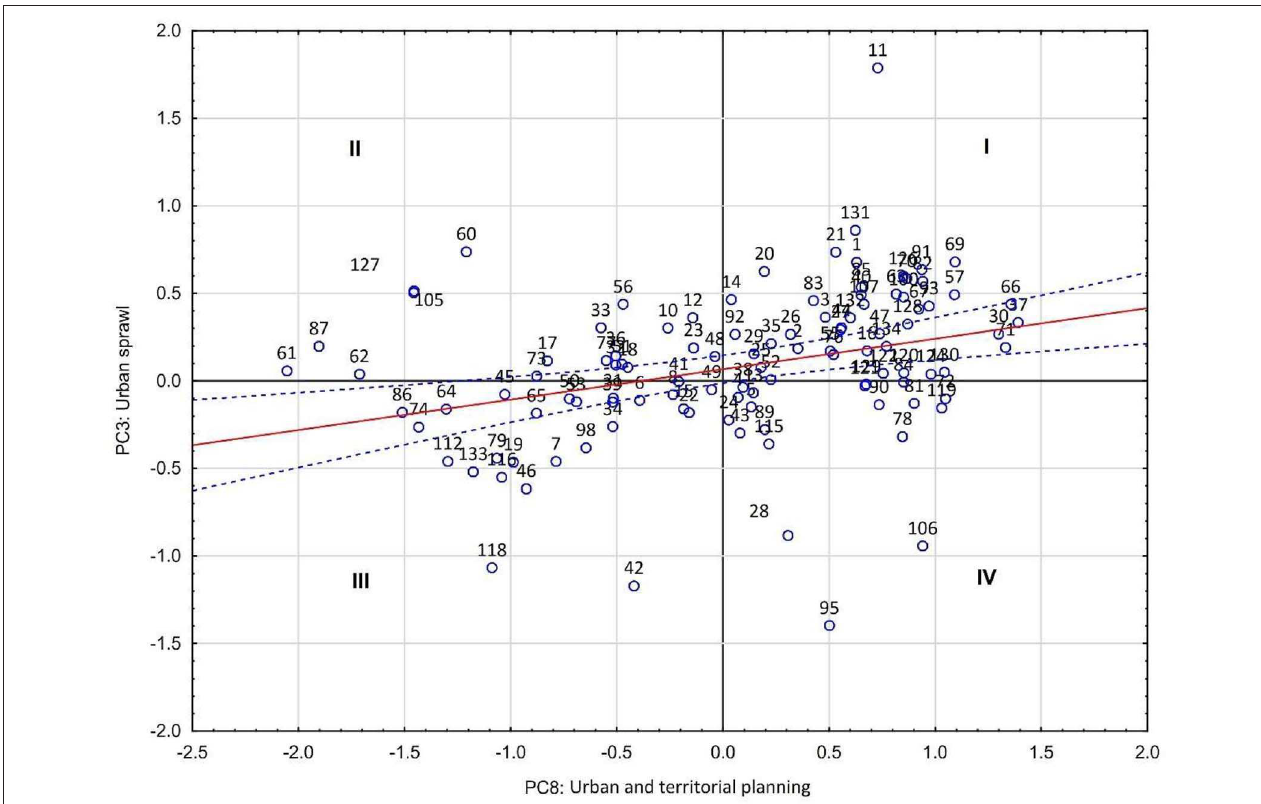
FIGURE 3 | Scatter plot of urban sprawl index (PC3) and urban and territorial planning index (PC8). The regression line is: PC3 = 0.07 + 0.33PC8; the slope coefficient is significant at the 5% level. Cozumel and San Cristobal de las Casas are outlying values in PC3 and PC8, respectively, and were excluded from this analysis and figure. A list of names and ID numbers of Mexican cities is provided in Table A2 .